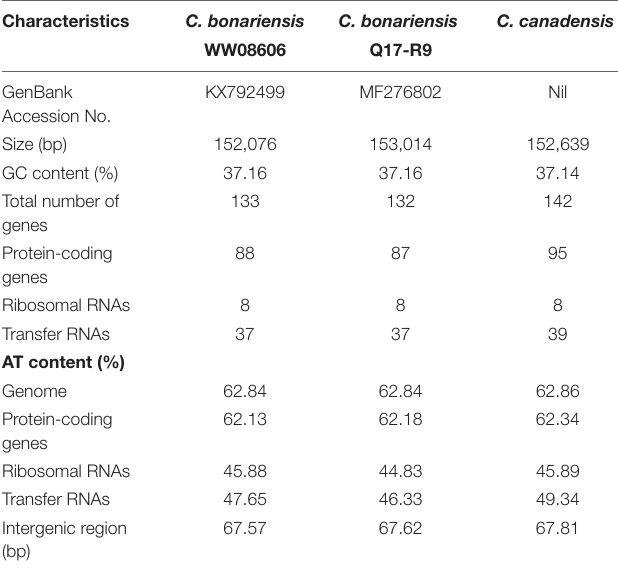
TABLE 1 | The cp genome features of C. bonariensis WW08606, C. bonariensis Q17-R9, and C.